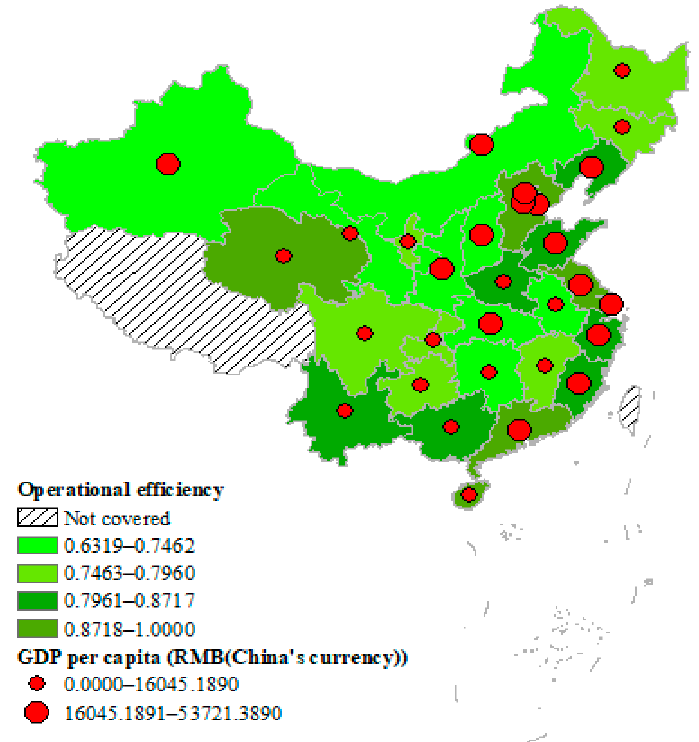
Figure 5. The spatial distribution of operational efficiency and GDP per capita. Table 5. Summary of efficiency measures in different groups.